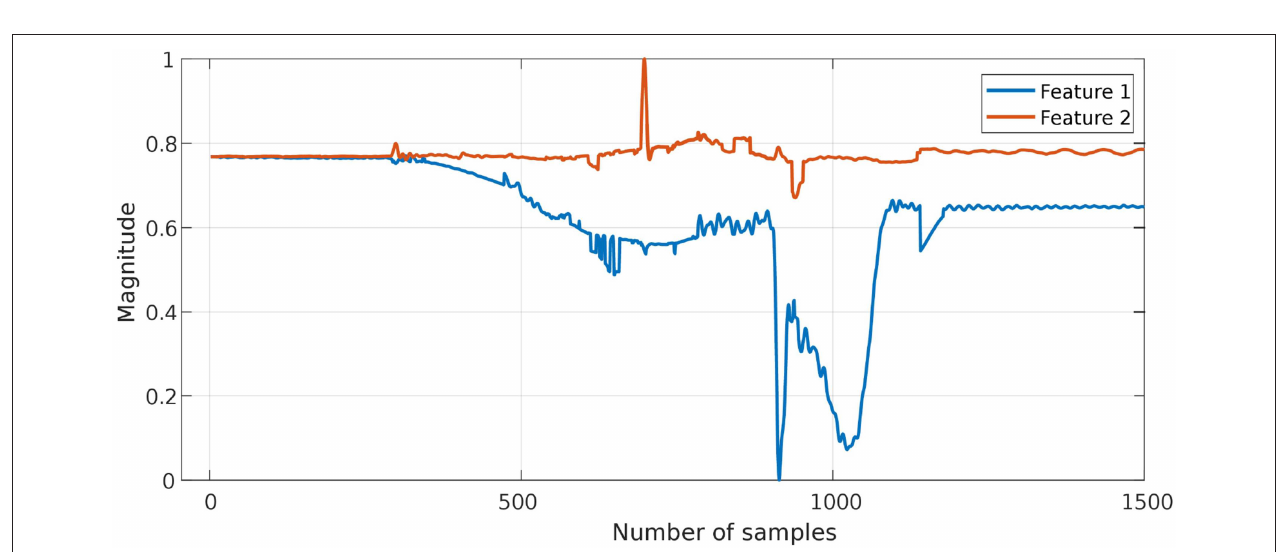
FIGURE 9 | Six-dimensional F/T signal during PiH assembly (original input data R 6